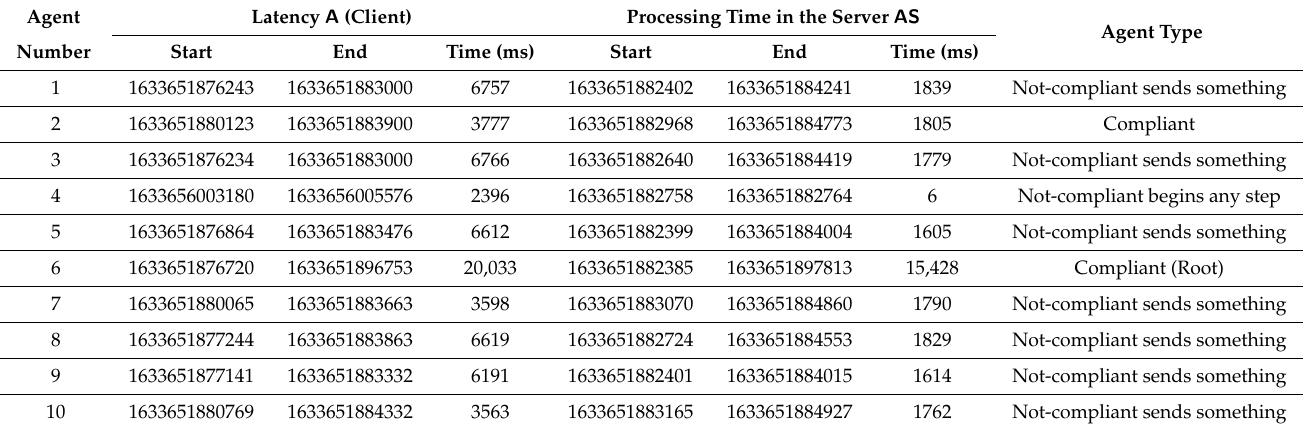
Table 4. Transaction latency from the client and processing time in the